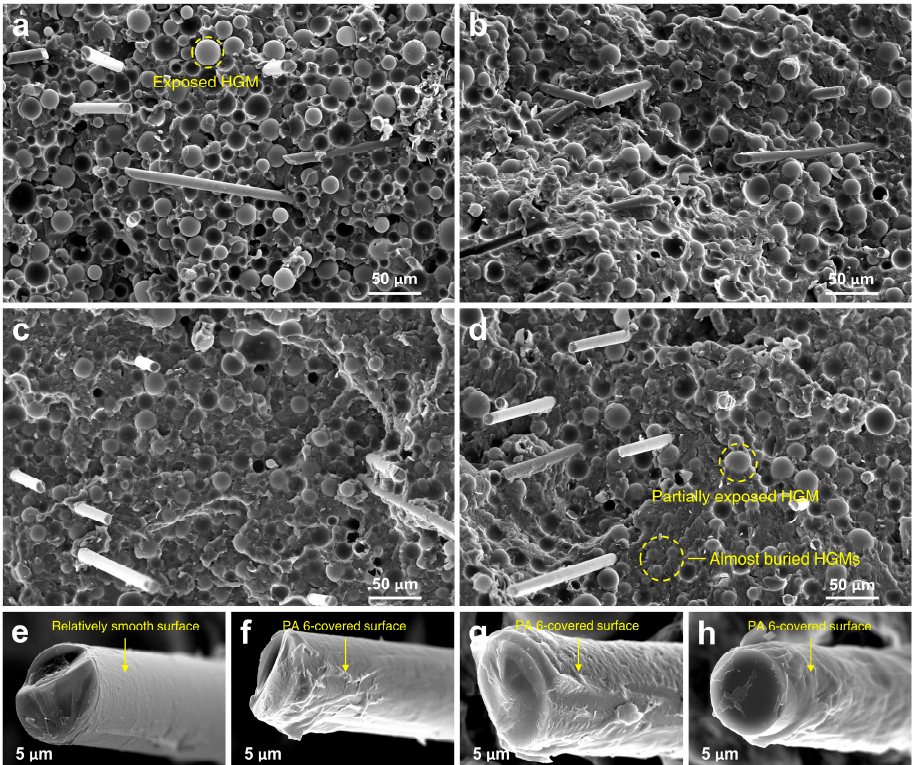
Figure 3. SEM microphotographs of fractured surface of the composite samples after tensile testing: ( a ) RSF control, ( b ) RSF-COOH 0.5, ( c ) RSF-COOH 1.0, and ( d ) RSF-COOH 2.0. Enlarged micropho- tographs of the GFs which are in the ( e ) RSF control, ( f ) RSF-COOH 0.5, ( g ) RSF-COOH 1.0, and ( h ) RSF-COOH 2.0, respectively.